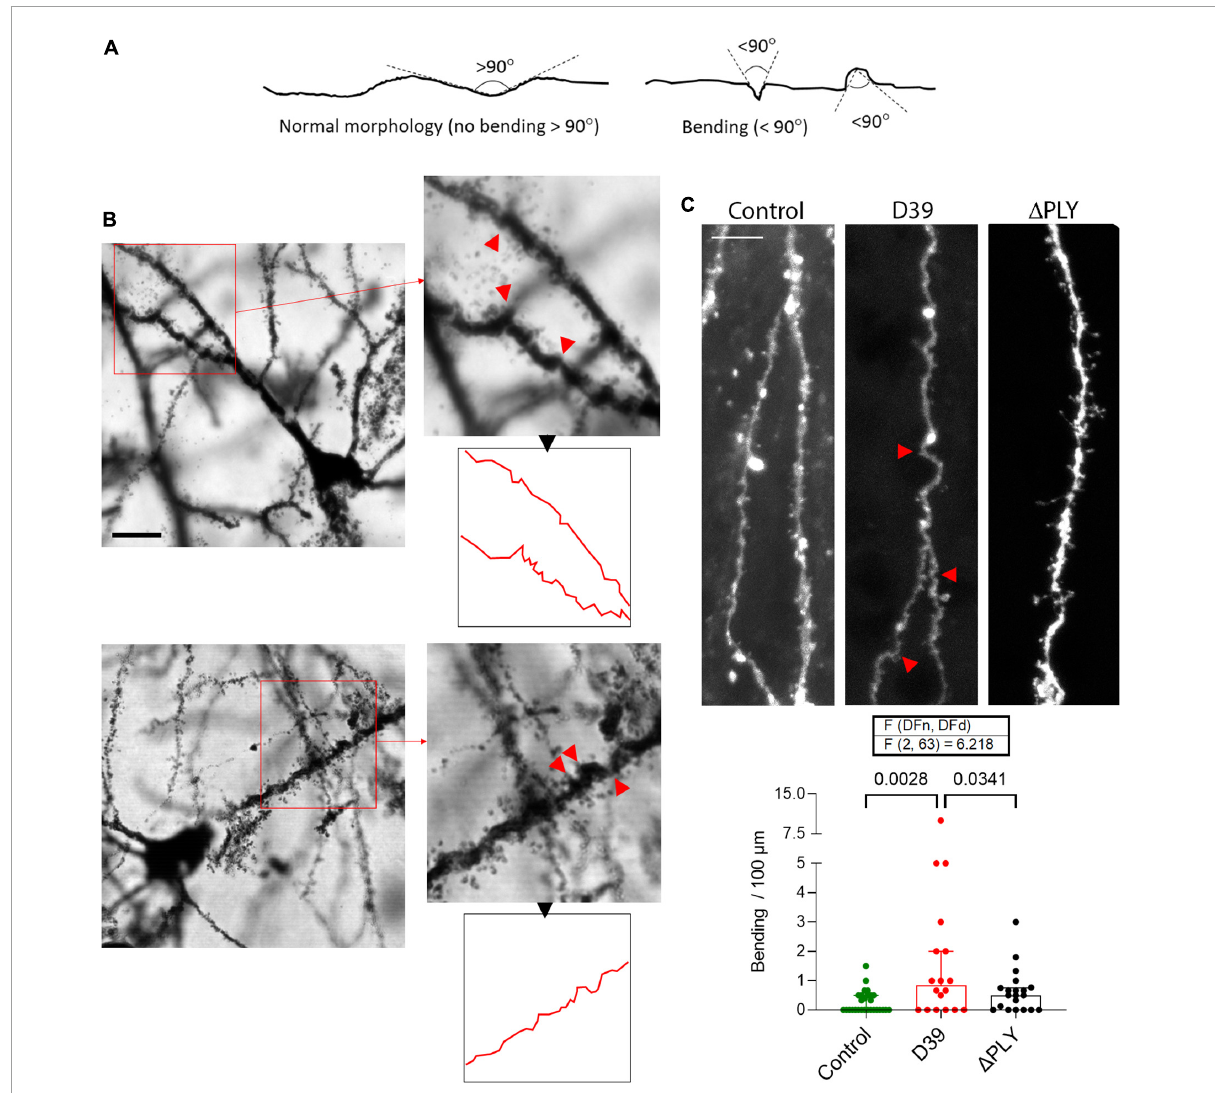
FIGURE5 Mechanic distortion of apical dendrites. (A) Morphological criteria for determination of the bending in dendrites. Any fragment of the dendrites with neighboring elements at an angle of 90 ◦ or lower is considered bended. (B) Example of two neurons (layer 4) from two animals, representative of the multiple neurons in their neocortex with massive mechanical twisting/bending. Red arrows indicate the sharply bended/distorted fragments of the dendrites, outline in red demonstrates the neurite contours. Scale bar: 10 µ m. (C) Analysis of the number of distorted points ( < 90 ◦ bending) per 100 µ m of DiI-strained primary apical dendrites of cortical pyramidal neurons in acute brain slices treated for 6 h with bacterial lysates originating from wild-type D39 pneumococci (D39) or from D39 pneumococci with knocked-out PLY gene ( (cid:49) PLY). All values represent median ± 95% CI, One-way ANOVA, exact p -value is presented on the graph (if below 0.05). The number of analyzed neurons in each group is indicated by the symbol points in the graph (mock-treated (control), n = 28 neurons; D39, n = 18 neurons; (cid:49) PLY, n = 20 neurons), on average 1–2 neurons per acute